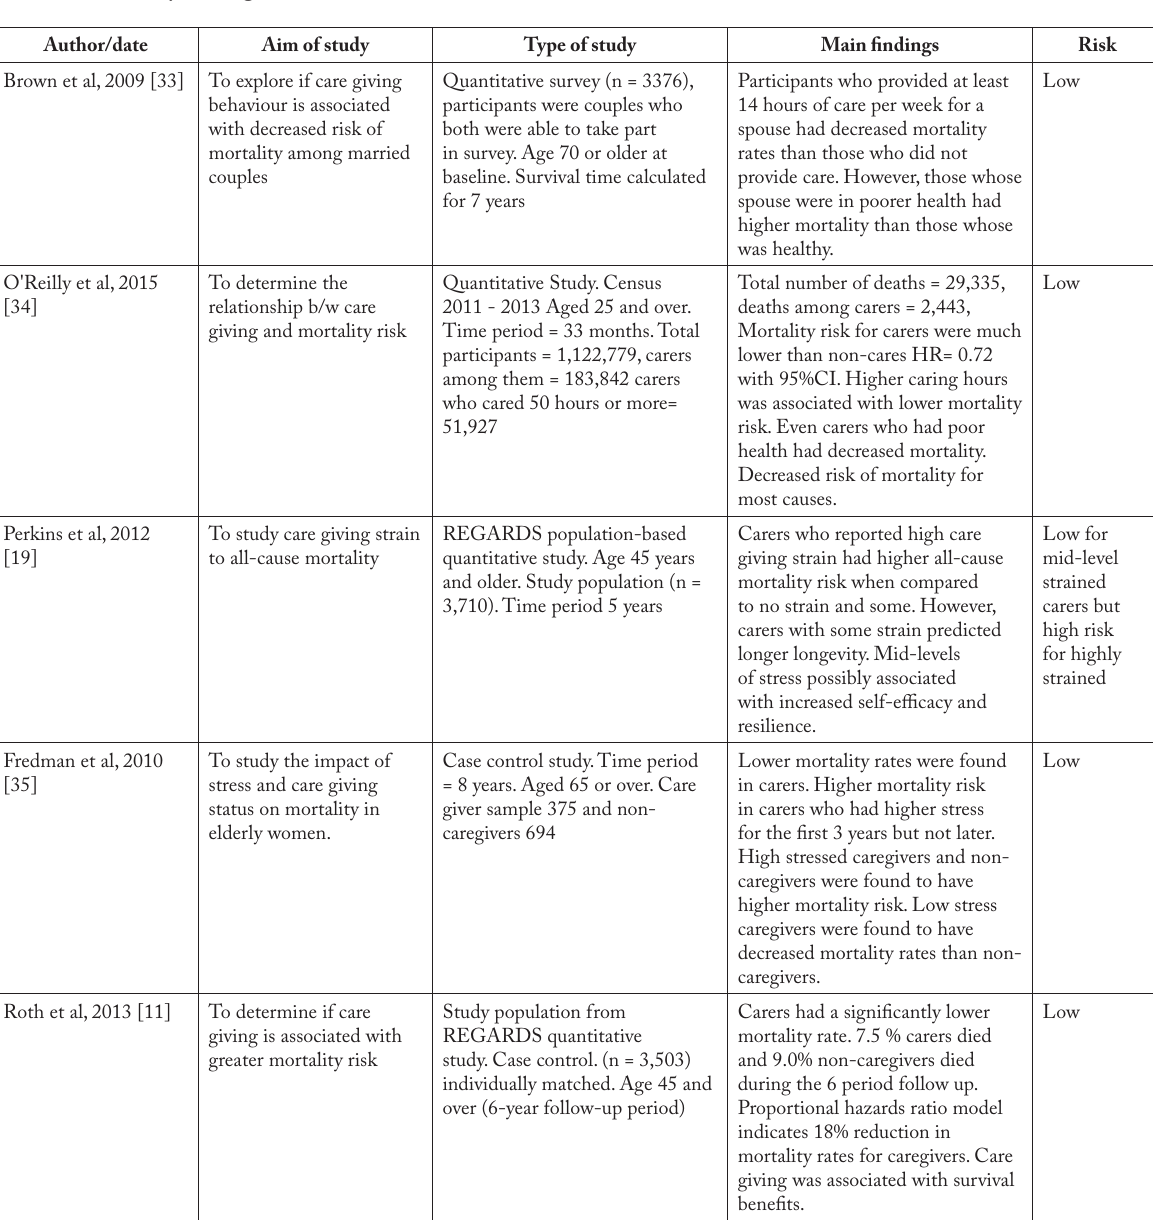
Table 6. Mortality among